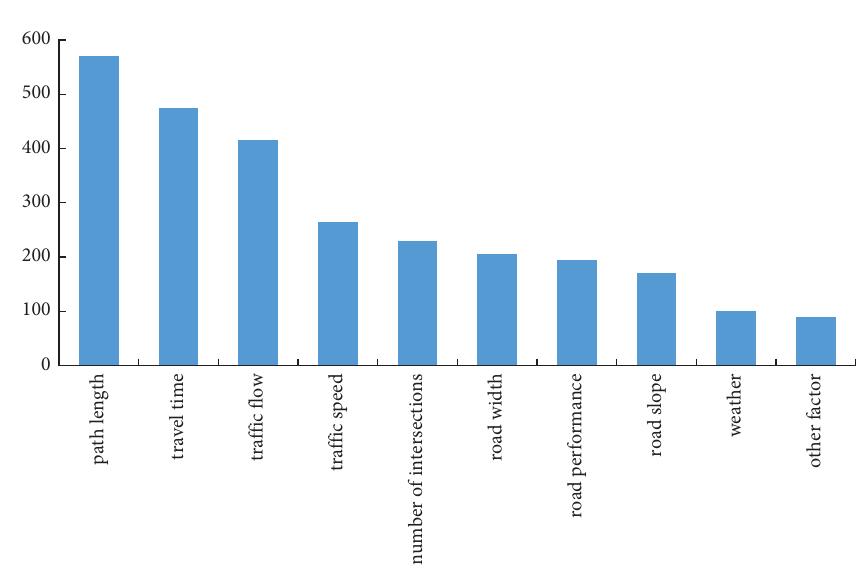
Figure 1: Statistical distribution diagram of various infuencing factors afecting path optimization.